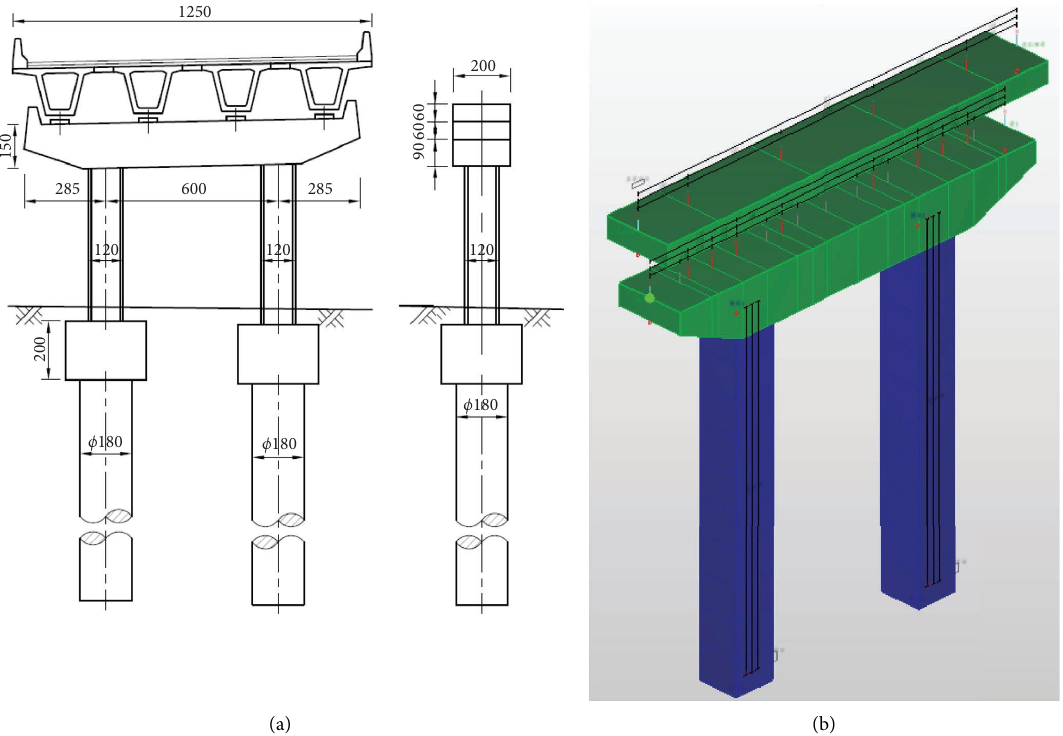
Figure 2: Overview of the prototype and fnite element model. (a) Te cross-section view (unit: cm). (b) Te fnite element model.